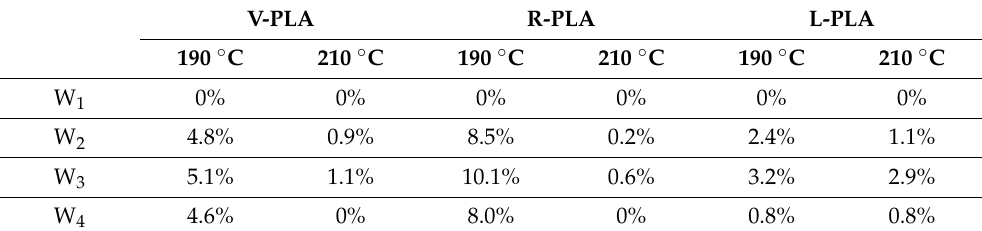
Figure 2. ( a ) Schematic of warping deformation (W = H max -H); ( b ) edges depiction of the 3D object used for measuring warpage. ∗ 100 ) for each edge (W1, W2, W3, W4) of 3D Table 3. Warping deformation (%) ( W = H max − H H max printed object at printing temperatures of 190 and 210 ◦ C, respectively. Measurements have been conducted through the auxilium of a caliber.